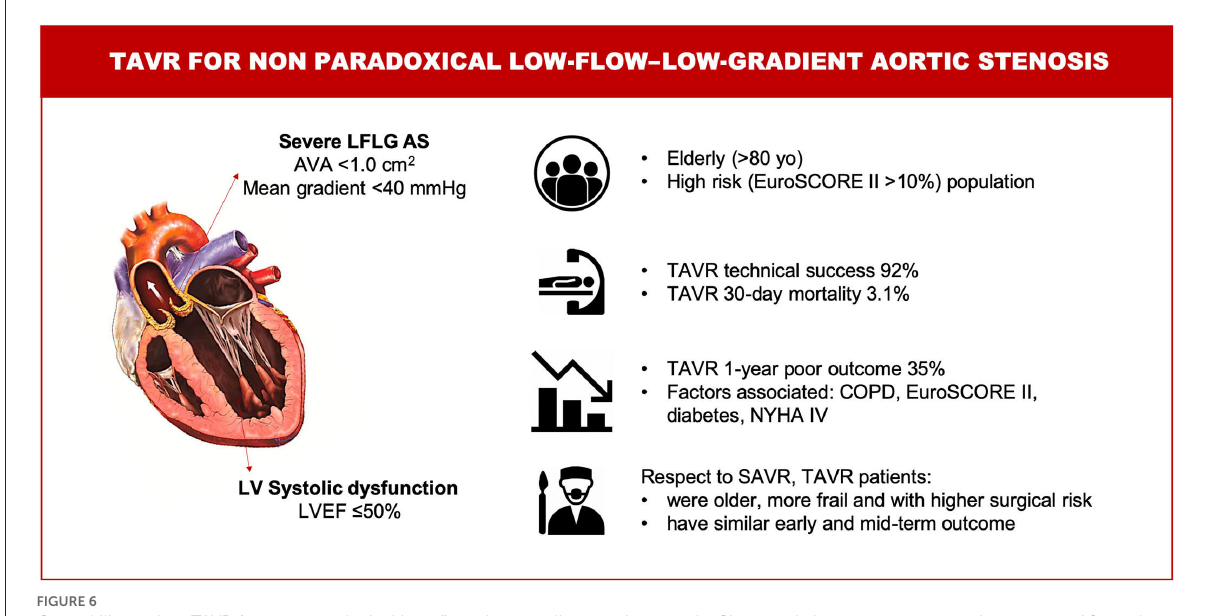
FIGURE6 Central illustration. TAVR for non-paradoxical low-flow–low-gradient aortic stenosis. Characteristics, management and outcomes. AS, aortic stenosis; AVA, aortic valve area; COPD, chronic obstructive pulmonary disease; LV, left ventricular; LVEF, left ventricular ejection fraction; LFLG, low-flow – low-gradient; NYHA, New York Heart Association; SAVR, surgical aortic valve replacement; TAVR, transcatheter aortic valve